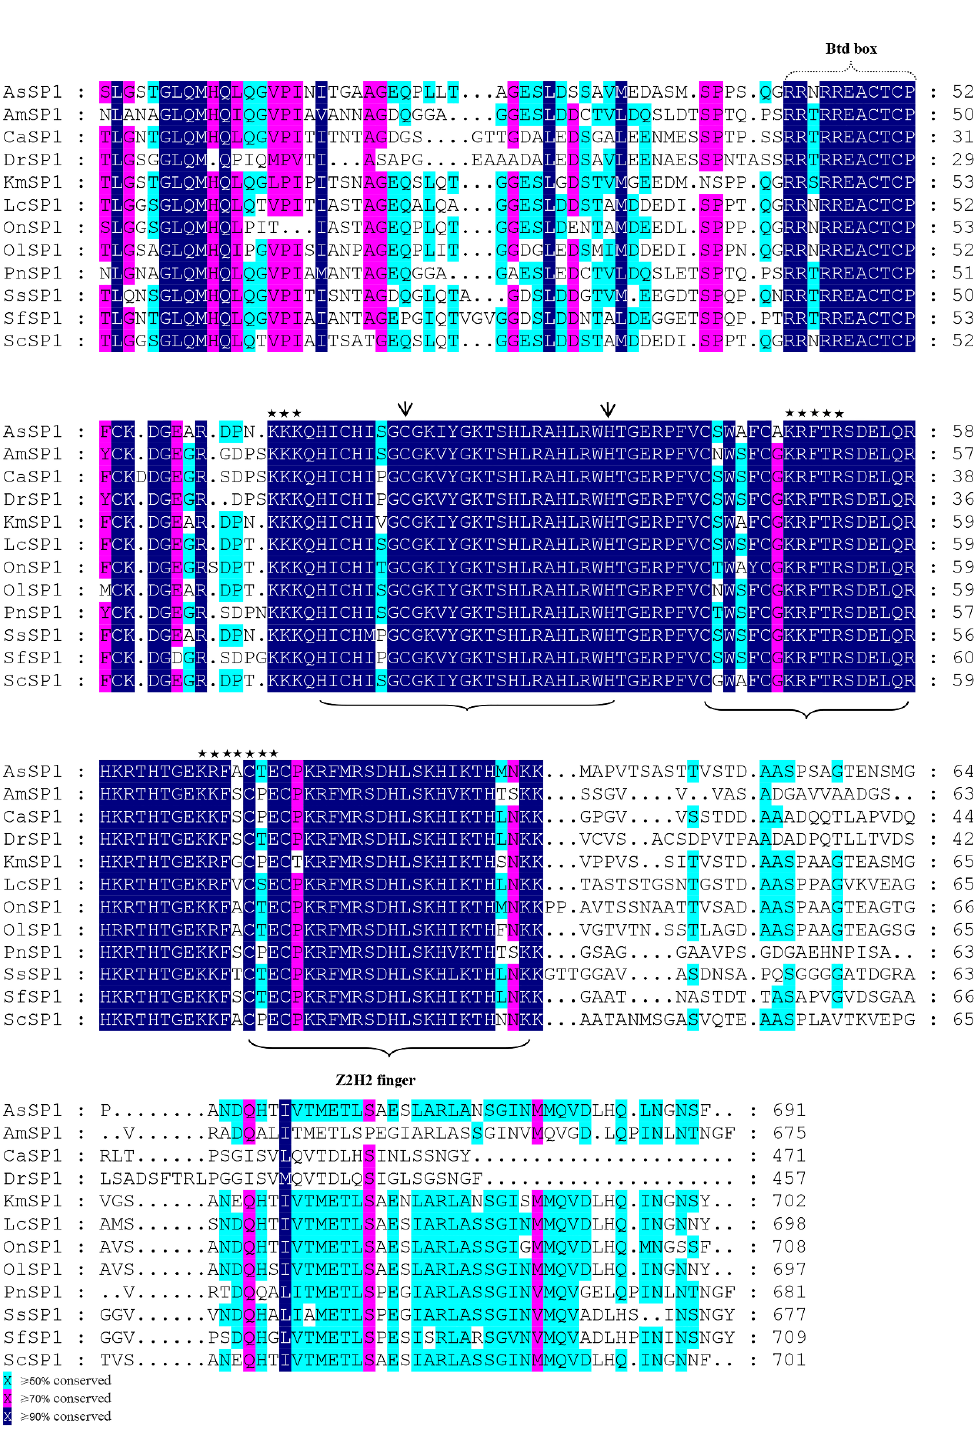
Figure 1. Alignments of the deduced amino acid (aa) sequences of Sp1 Btd box and zinc finger domains from Siganus canaliculatus (ScSP1) and other fish species ( Larimichthys crocea , LcSP1, XP_010730401.1; Salmo salar , SsSP1, XP_013989519.1; Aphyosemion striatum AsSP1, SBP16265.1; Astyanax mexicanus , AmSP1, XP_007248419.1; Kryptolebias marmoratus , KmSP1, XP_017264015.1; Oreochromis niloticus , OnSP1, XP_019214905.1; Oryzias latipes , OlSP1, XP_004068725.1; Pygocentrus nattereri , PnSP1, XP_017548304.1; Scleropages formosus , SfSP1, XP_018597836.1; Danio rerio , DrSP1, AAH67713.1). The black and gray boxes indicate identical and similar aa residues, respectively. The dotted-line brackets indicate Btd box. The solid braces denote zinc finger domains. The pentagrams and arrows indicate potential phosphorylation sites and Zn binding